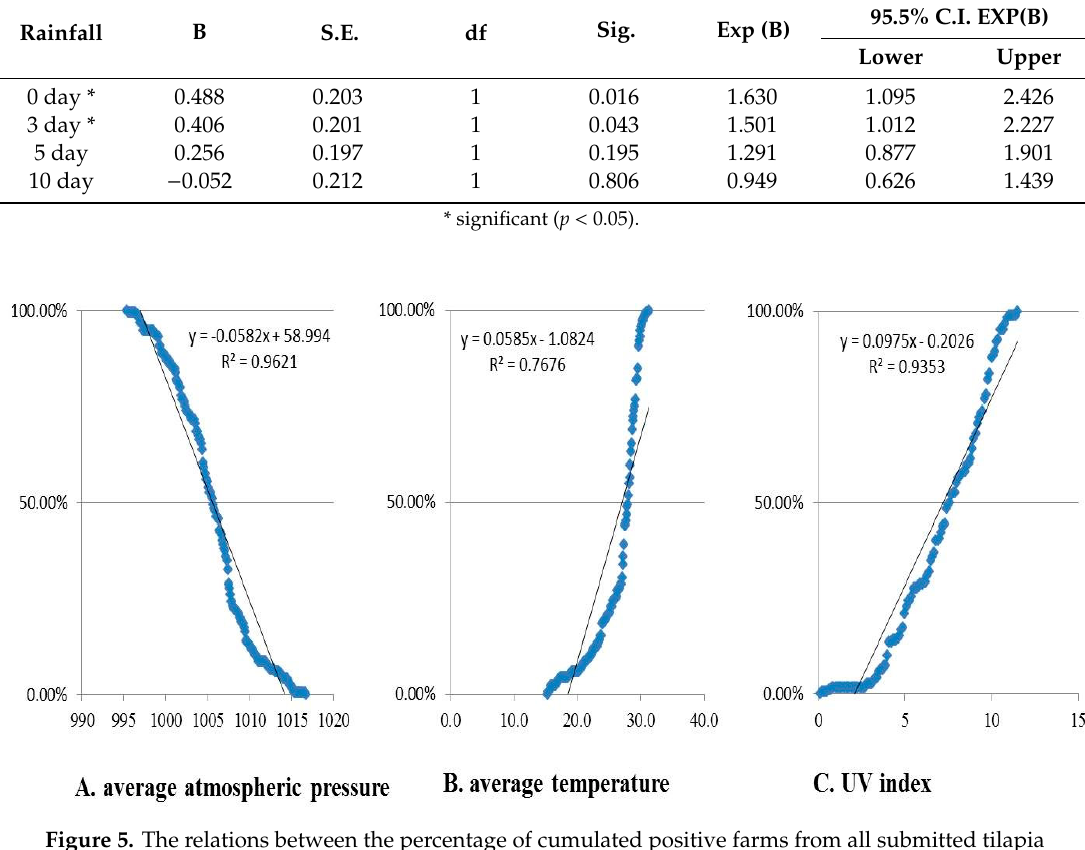
Figure 5. The relations between the percentage of cumulated positive farms from all submitted tilapia cases and climate factors: ( A ) average atmospheric pressure; ( B ) average temperature; ( C ) UV index. When the average temperature is 27.0 °C, the average atmospheric pressure is 1005.1 hPa, or the UV index is 7.2, the percentage of cumulated positive farms from all submitted tilapia cases reached 50%.